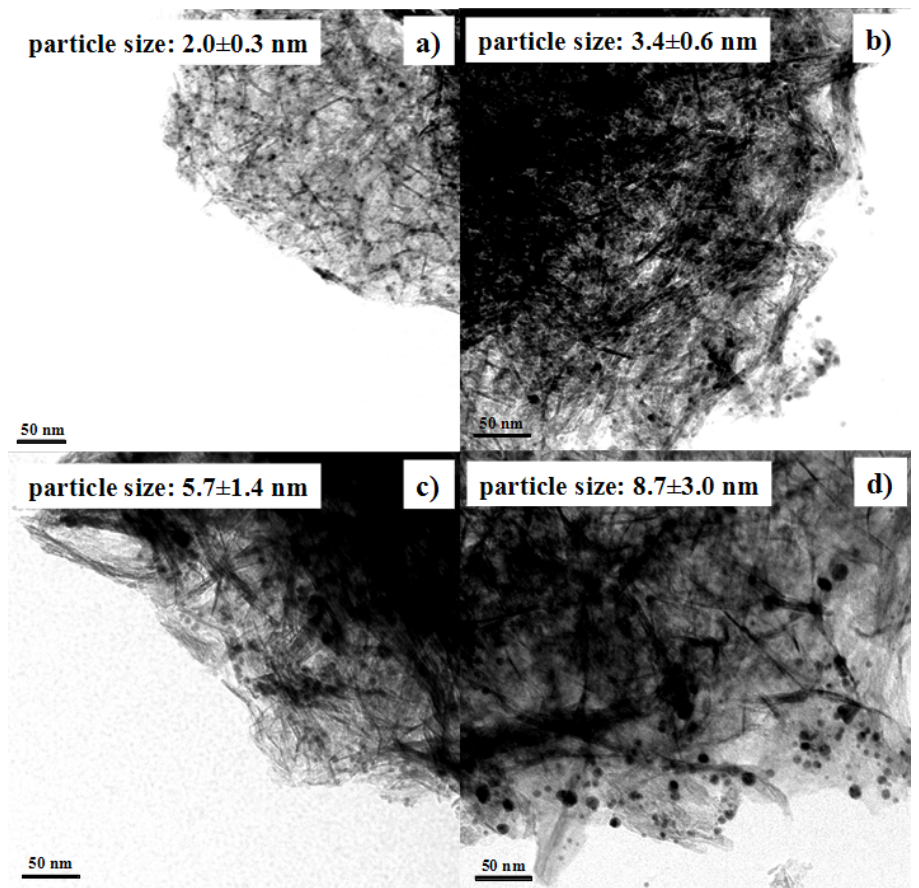
Figure 5. TEM images showing Au/Al particle sizes: ( a ) 1.7 nm; ( b ) 3.4 nm; ( c ) 5.7 nm; ( d ) 8.2 nm.